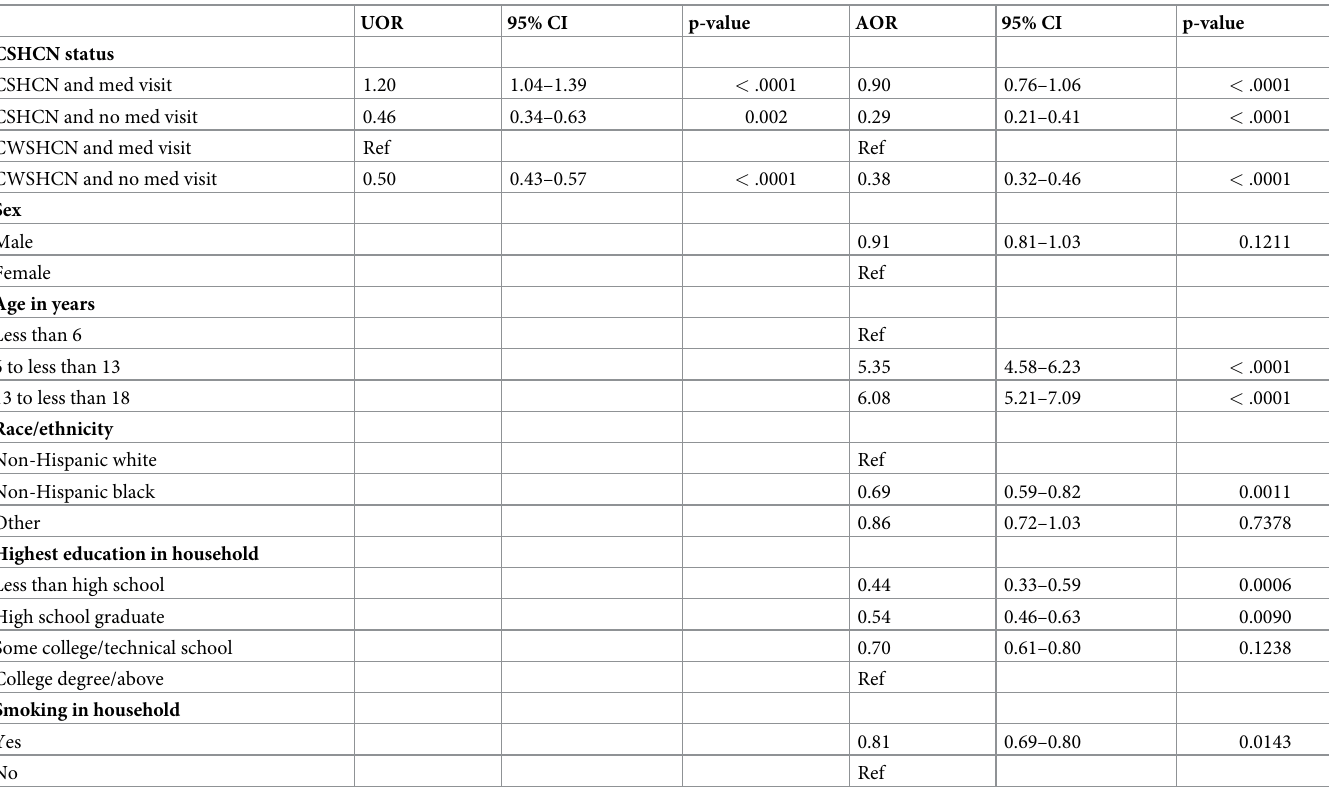
Table 3. Logistic regression on having a dental preventive visit within the past 12 months, national survey of children’s health,